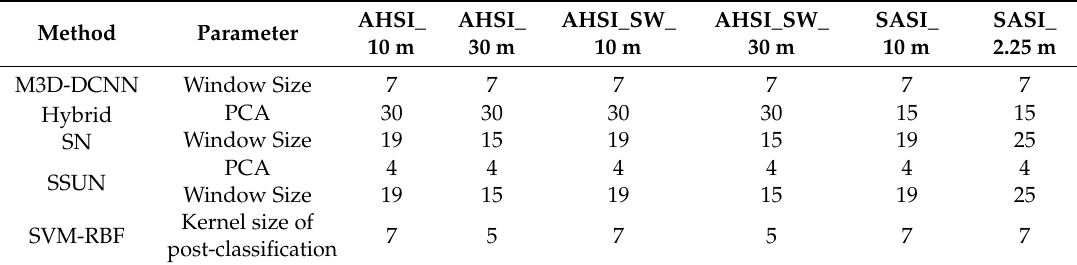
Table 7. Parameter settings of di ff erent models.